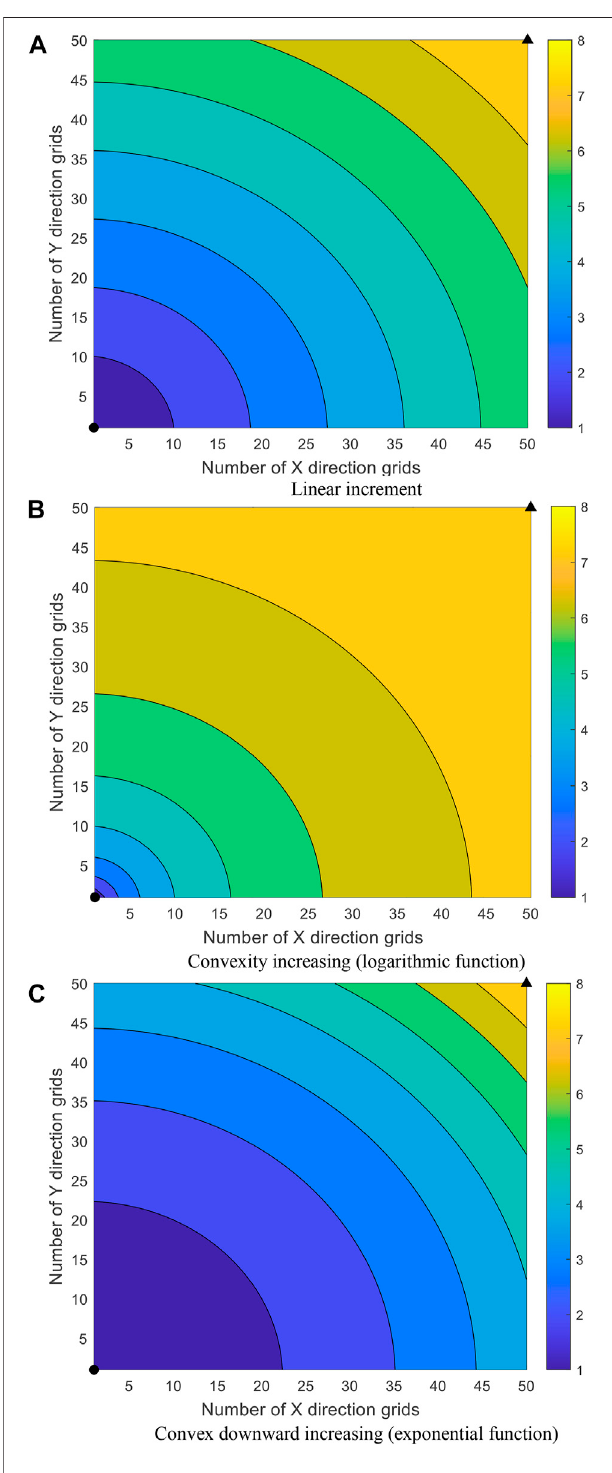
FIGURE 6 | Permeability three heterogeneous distributing graph. (A) Linear increment, (B) Convexity increasing (logarithmic function) and (C) Convex downward increasing (exponential